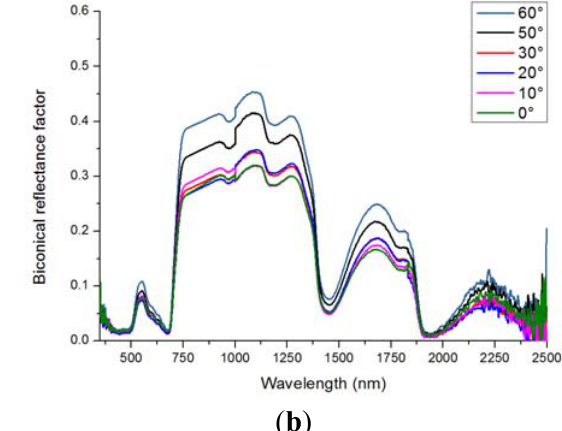
Figure 4. Lawn grass reflectance at a 10°, 20°, 30°, 50° and 60° viewing zenith angle in the principal plane at an illumination angle of 45°: ( a ) is the 18 days old lawn grass in the backward scatter direction; and ( b ) is the 18 days old lawn grass in the forward scatter direction. In both graphs a measurement from the nadir position (zenith angle is 0°) is included as a